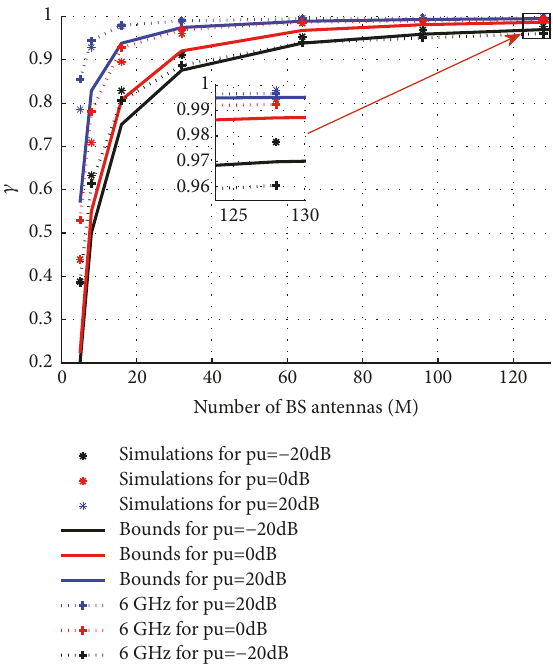
Figure 7: Simulation and 6 GHz measurement results of 𝛾 versus different numbers of BS antennas with different transmit